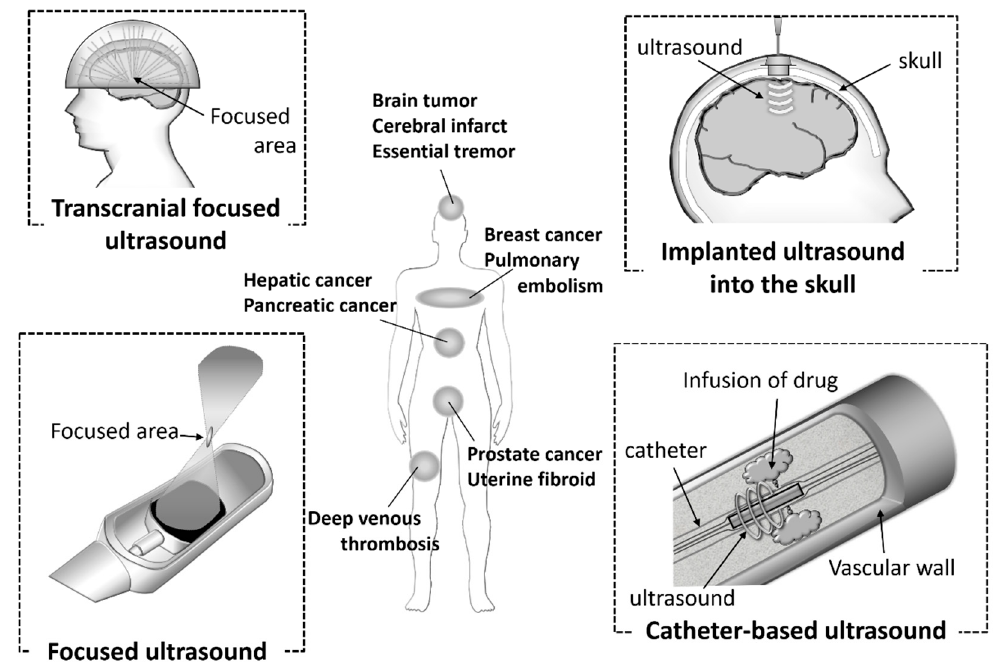
Figure 4. Ultrasound devices used in clinical settings.